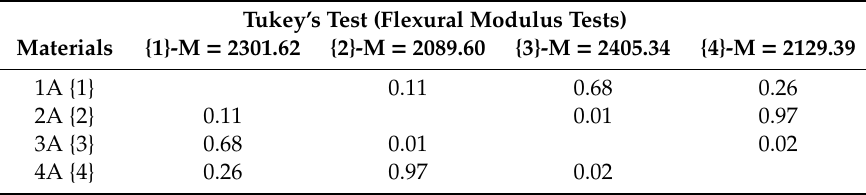
Table 6. Tukey’s test results.